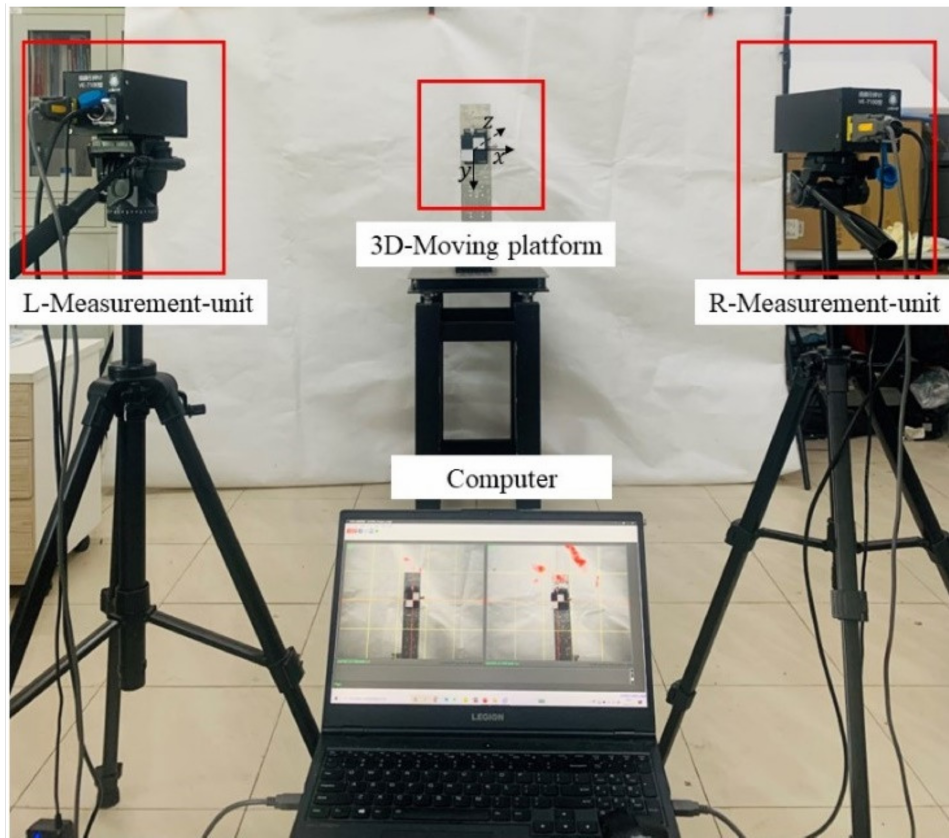
Figure 9. Indoor experimental